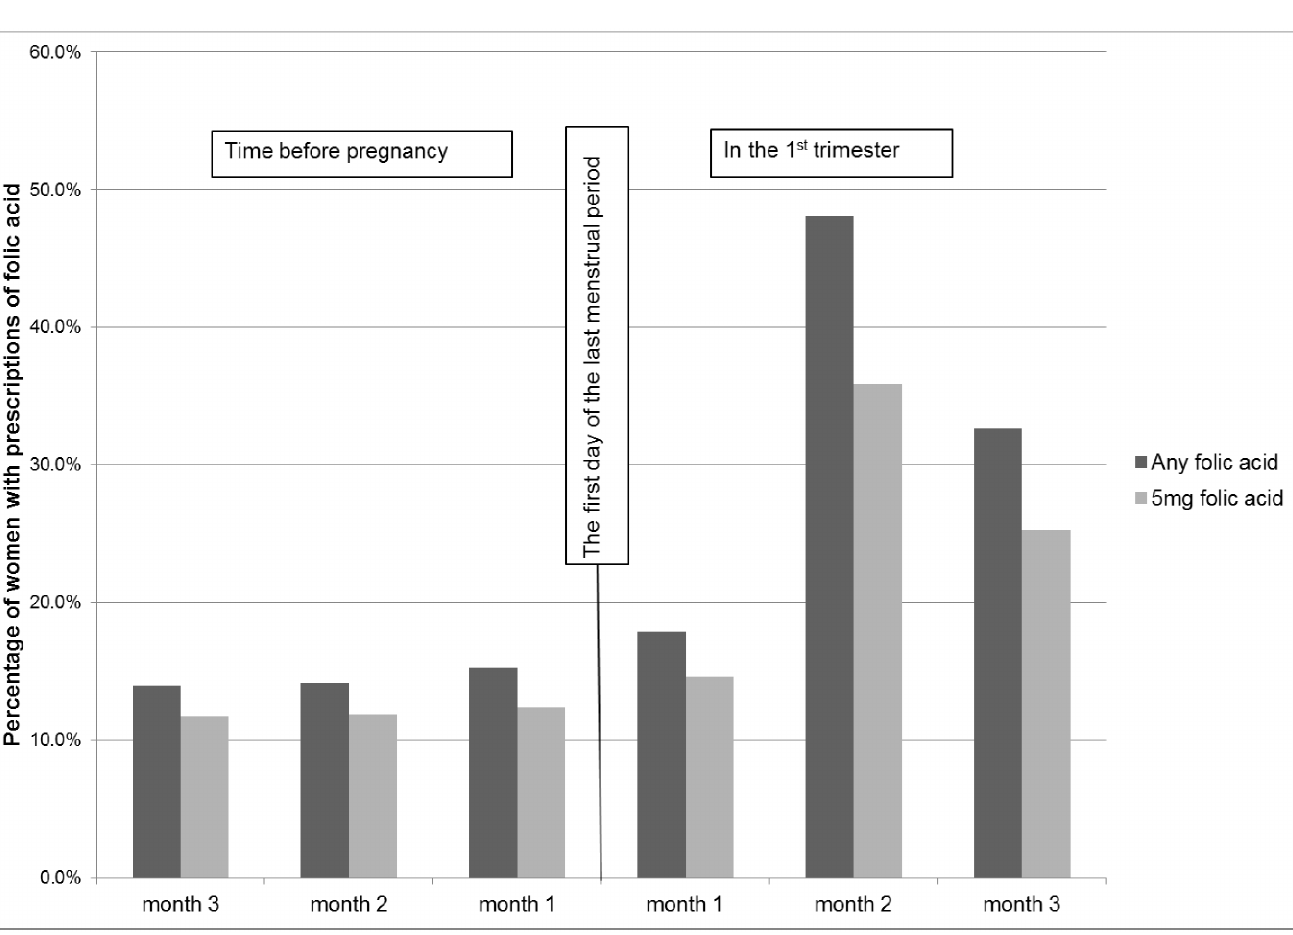
Fig 1. Percentages of women prescribed folic acid among those with first trimester antiepileptic drug prescriptions (N = 1,259). Monthly prevalence of any folic acid and 5mg folic acid prescribed in the three months before pregnancy and in the first trimester.